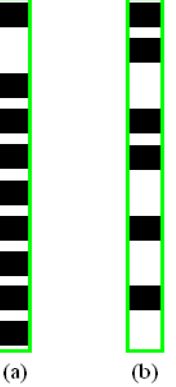
Figure 8. Example of a dense piece and sparse piece: ( a ) dense piece; ( b ) sparse piece. The black area represents characters, and the white area represents blank spaces.